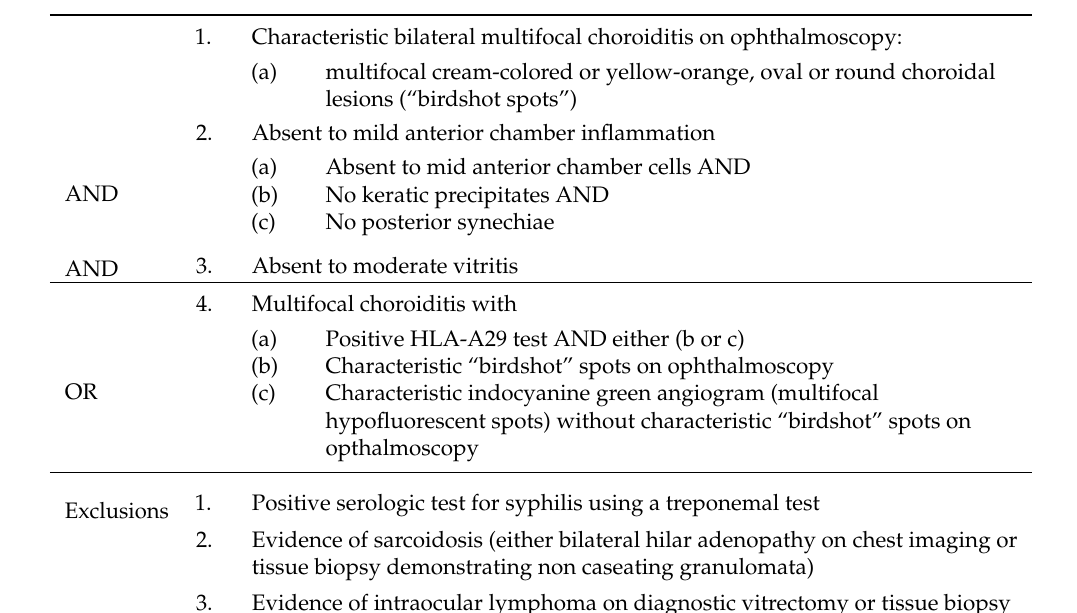
Table 1. Birdshot Chorioretinopathy Diagnostic Criteria (adapted from the Standardization of